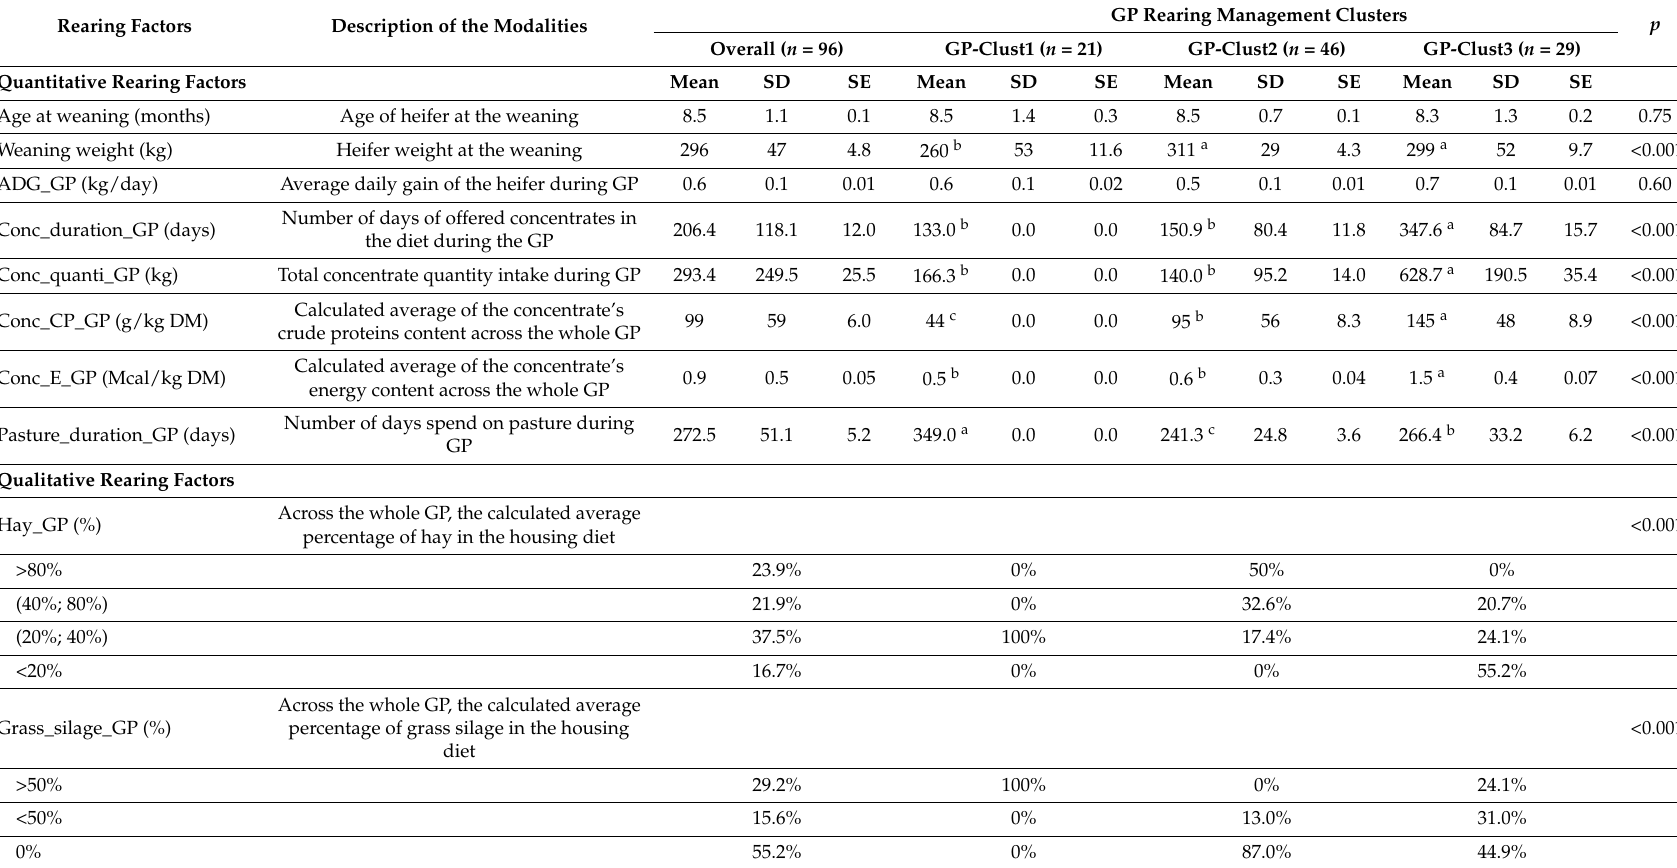
Table 2. Description of the rearing factors characterizing the growth period (GP) and the GP rearing management clusters obtained for this period (GP-clust). Rearing